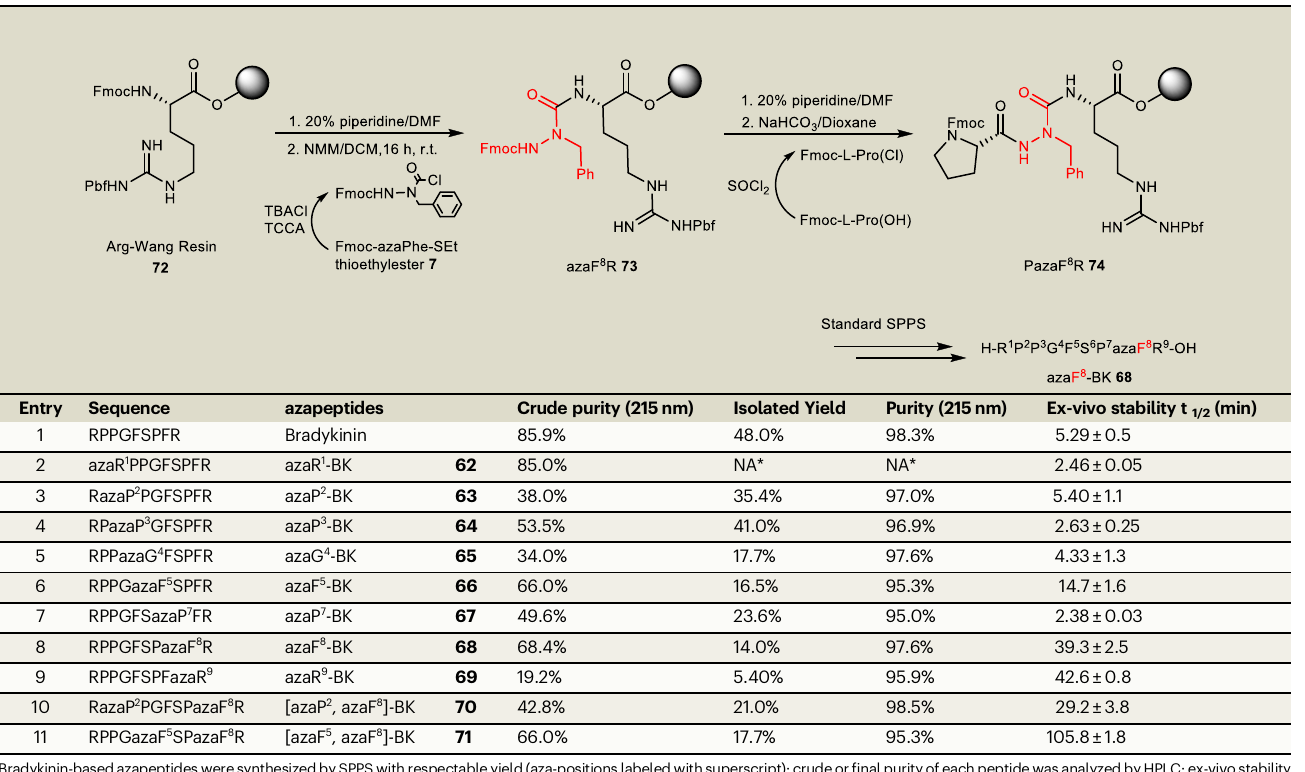
Table 4 | Summary of bradykinin and BK-based azapeptide